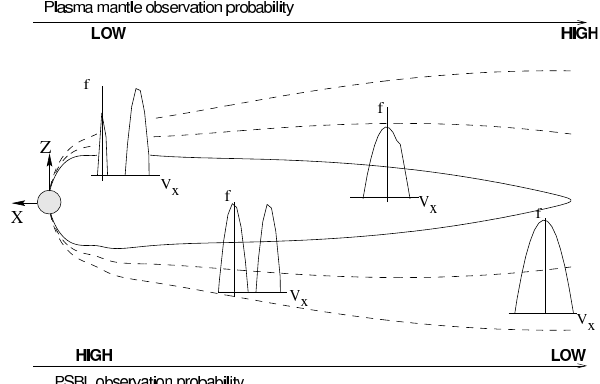
Fig. 7. A schematic diagram showing the model boundary, which is the magnetic field line that crosses the NS at X = − 100 R E (solid line). The probability of observing mantle/PSBL plasma in- creases/decreases with distance downtail. Model velocity distribu- tion functions at various positions along the boundary are shown as line drawings with the ordinate corresponding to phase space den- sity and the abscissa to the earthward velocity, V x